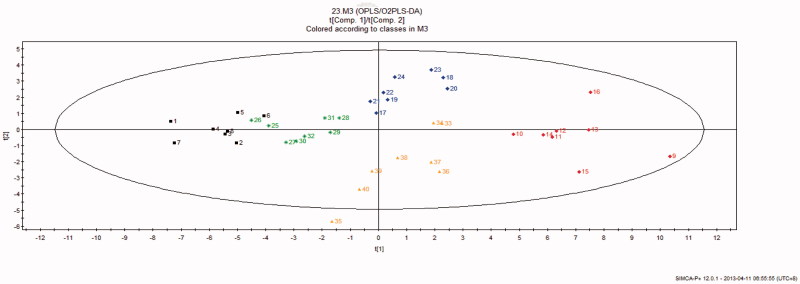
PLS-DA score plots of liver tissue homogenates Modelling Diagnostic: R2X = 0.311, R2Y = 0.930, Q = 0.78; 1–8, control; 9–16, BD; 17–24, ASH; 25–32, ASM; 33–40, ASL.